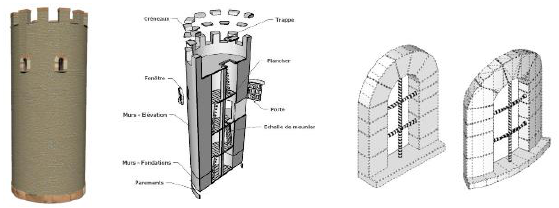
Figure 4. Round towers and windows